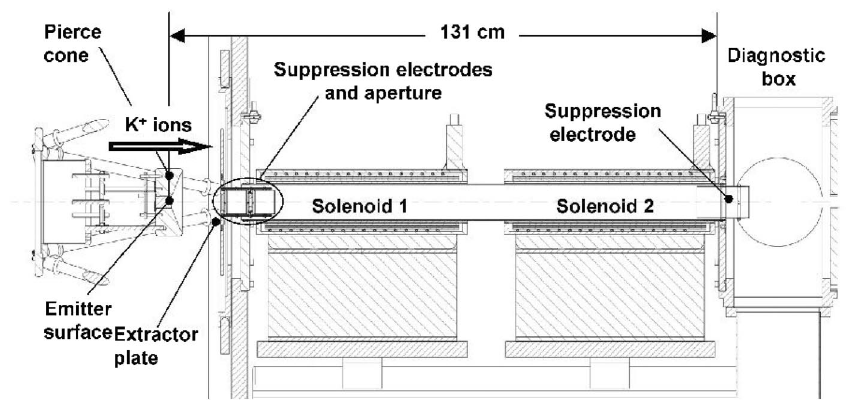
FIG. 6. Elevation view of the two-solenoid experiment.